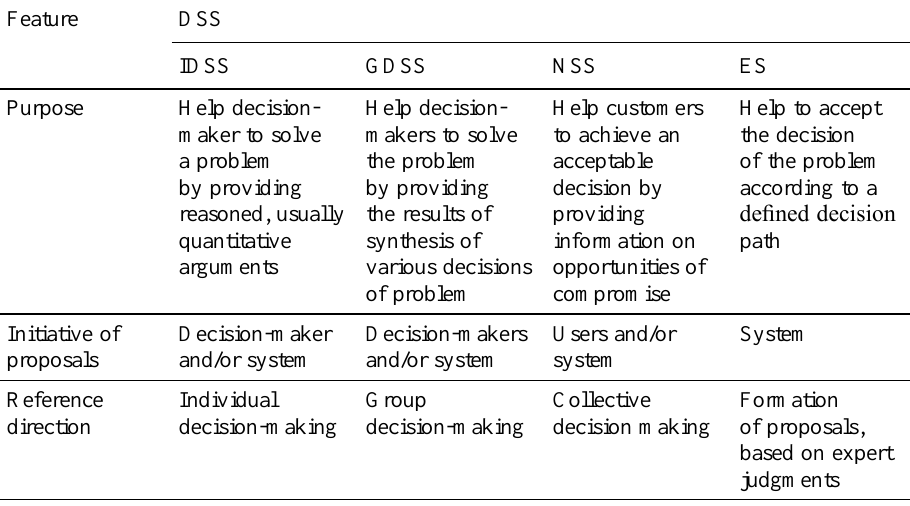
Table 1. The main qualities of the varieties of